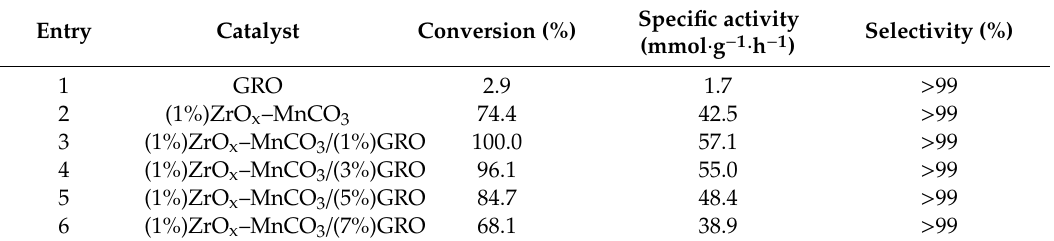
Table 1. Catalytic performances of various catalysts with di ff erent percentages of GRO for BzOH oxidation.